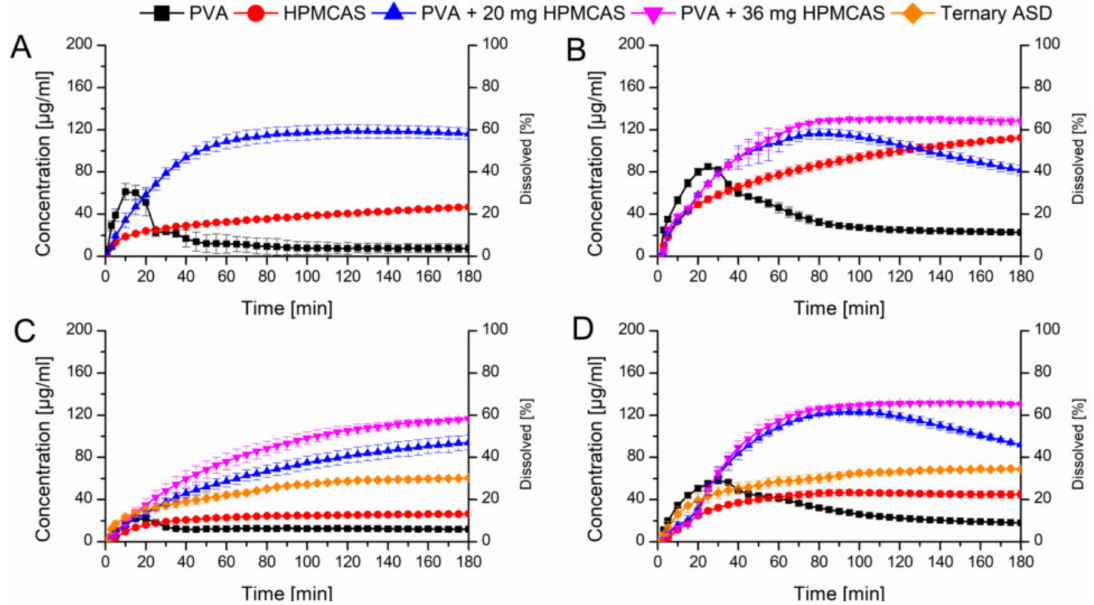
Figure 8. Monophasic non-sink dissolution studies of plain ASDs and of PVA ASDs with admixed HPMCAS powder at a drug load of 10% in PBS at pH 6.8 ( A ), in FaSSIF at pH 6.8 ( B ), at a drug load of 20%, including ternary ASD in PBS at pH 6.8 ( C ) and in FaSSIF at pH 6.8 ( D